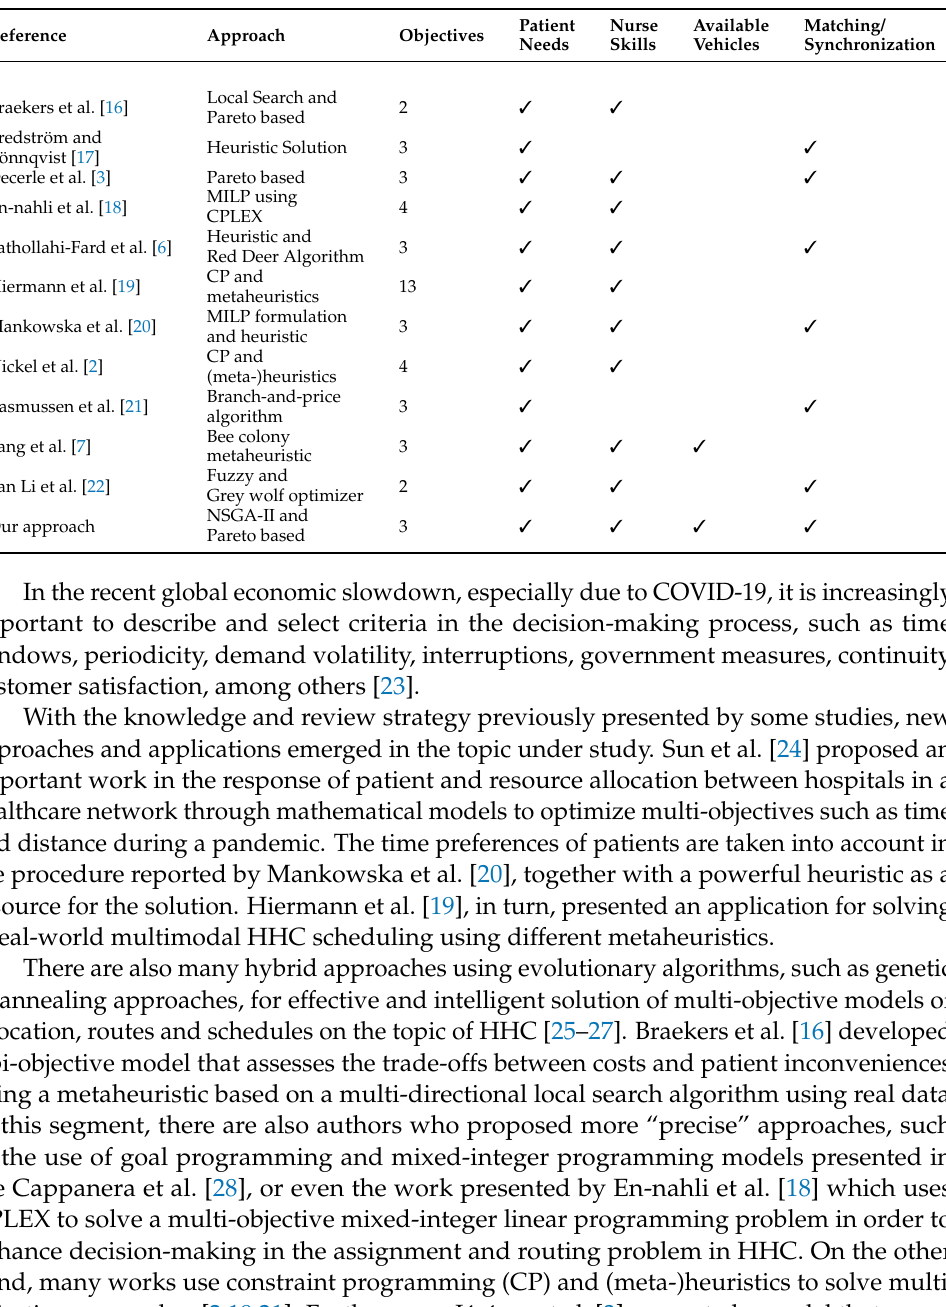
Table 1. Overview and assumptions regarding multi-objective approaches in Home Health